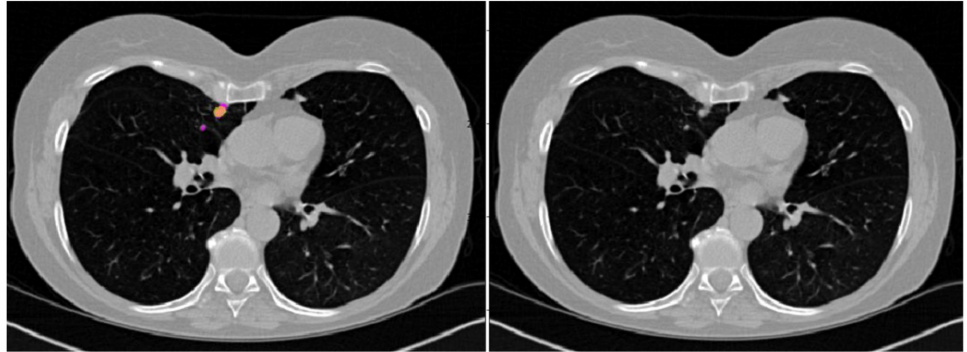
Figure 5. Example of a nodule close to pleura in the right lung correctly predicted by the CADe and of a small nodule, near to the previous one, missed by the CADe. Left panel: axial CT slice with prediction (yellow) and/or mask (pink); right panel: original CT